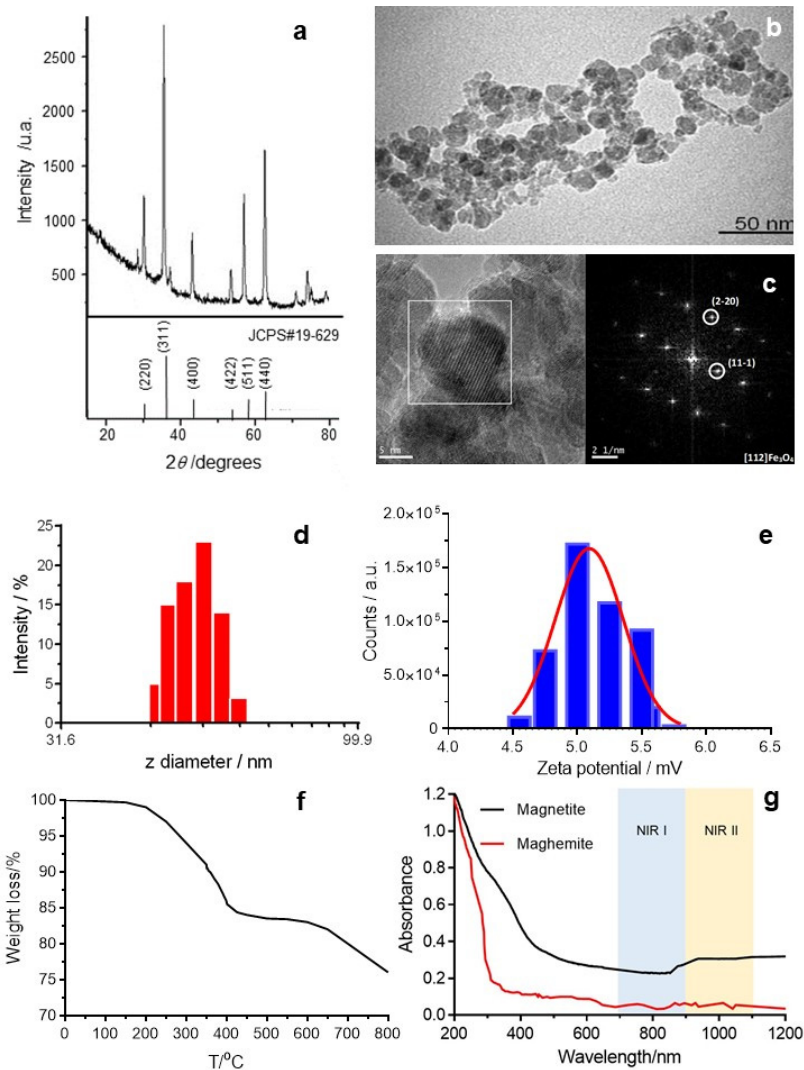
Figure 1. ( a ) X-ray diffraction (XRD) pattern, ( b ) transmission electron microscopy (TEM) image, ( c ) high-resolution (HR)-TEM images and the corresponding fast Fourier transform (FFT), ( d ) hydrodynamic radius of the as-prepared ferrofluid, ( e ) ζ -potential, ( f ) thermogravimetric analysis (TGA) and ( g ) UV-Vis-near-infrared (NIR) absorption spectrum of a suspension of 4.5 mM iron oxide nanoparticles (IONs) in water and after oxidation (maghemite at the same concentration).